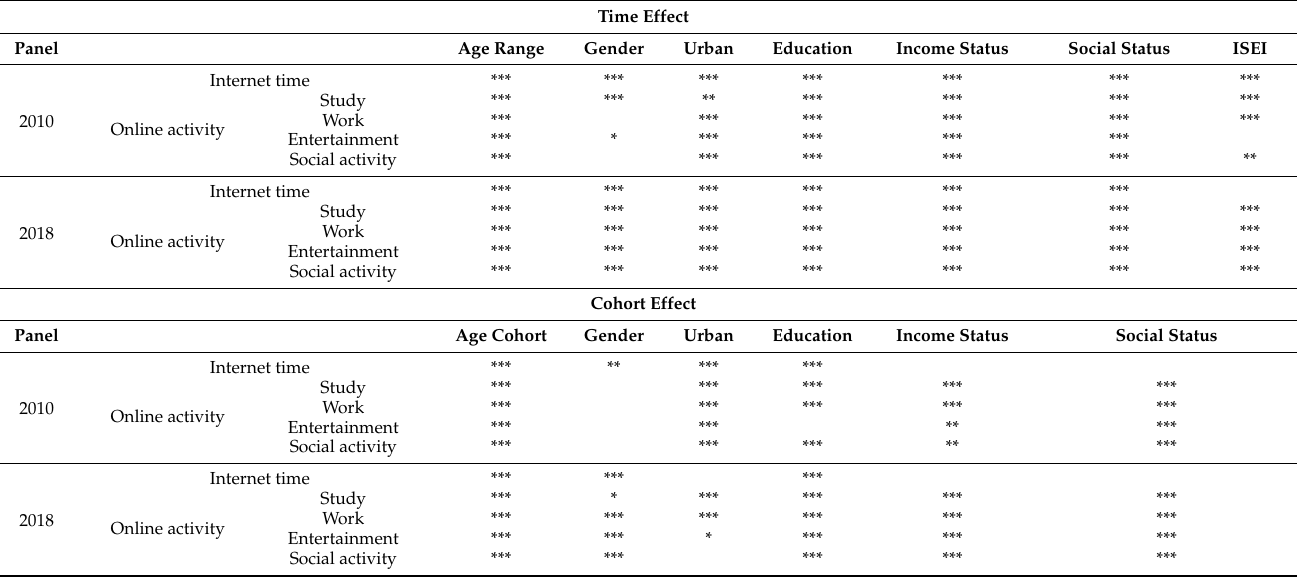
Table A1. Independence test between explanatory and explained variables using a chi-square